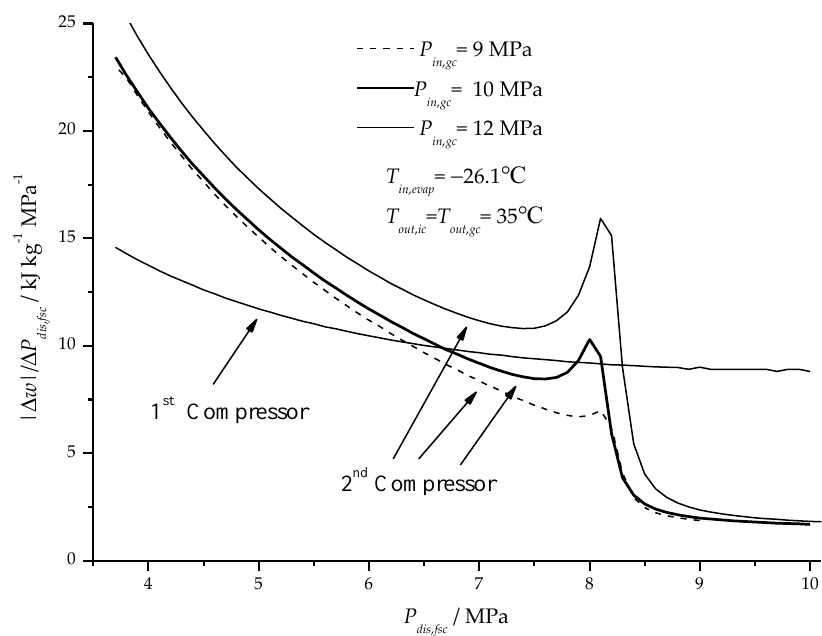
Figure 17. Variations of 1st and 2nd specific compression work at various gas cooler inlet pressures.